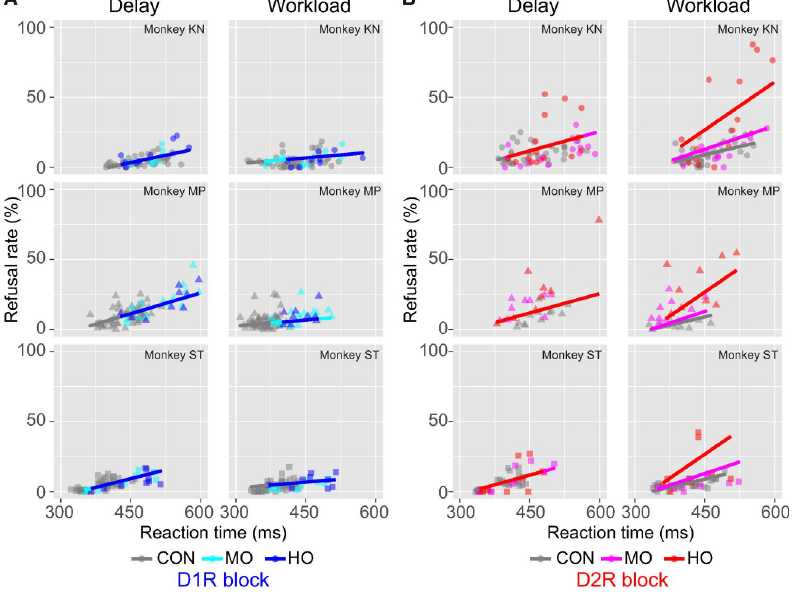
Fig 6. Relationship between refusal rate and RT in work/delay task. (A) Relationship between refusal rate and average RT for each remaining cost in session by session for D 1 R blocking in delay and workload trials. Data are plotted individually for monkeys KN, MP, and ST, in order from top to bottom. Colors indicate treatment condition. Thick lines indicate linear regression lines. (B) Same as A, but for D 2 R blocking. Note that for the data in workload trials under D 2 R treatment, a linear model with random effect of condition (model #4 in S4 Table) was chosen as the best model to explain the data, whereas for the other data, a simple linear regression model (model #1, without any random effect or model #2 with random effect of subject) was selected. The data underlying this figure can be found on the following public repository: https://github.com/minamimoto-lab/2021-Hori-DAR. CON, control; D 1 R, D 1 -like receptor; D 2 R, D 2 -like receptor; HO, high occupancy; MO, moderate occupancy; RT, reaction time.